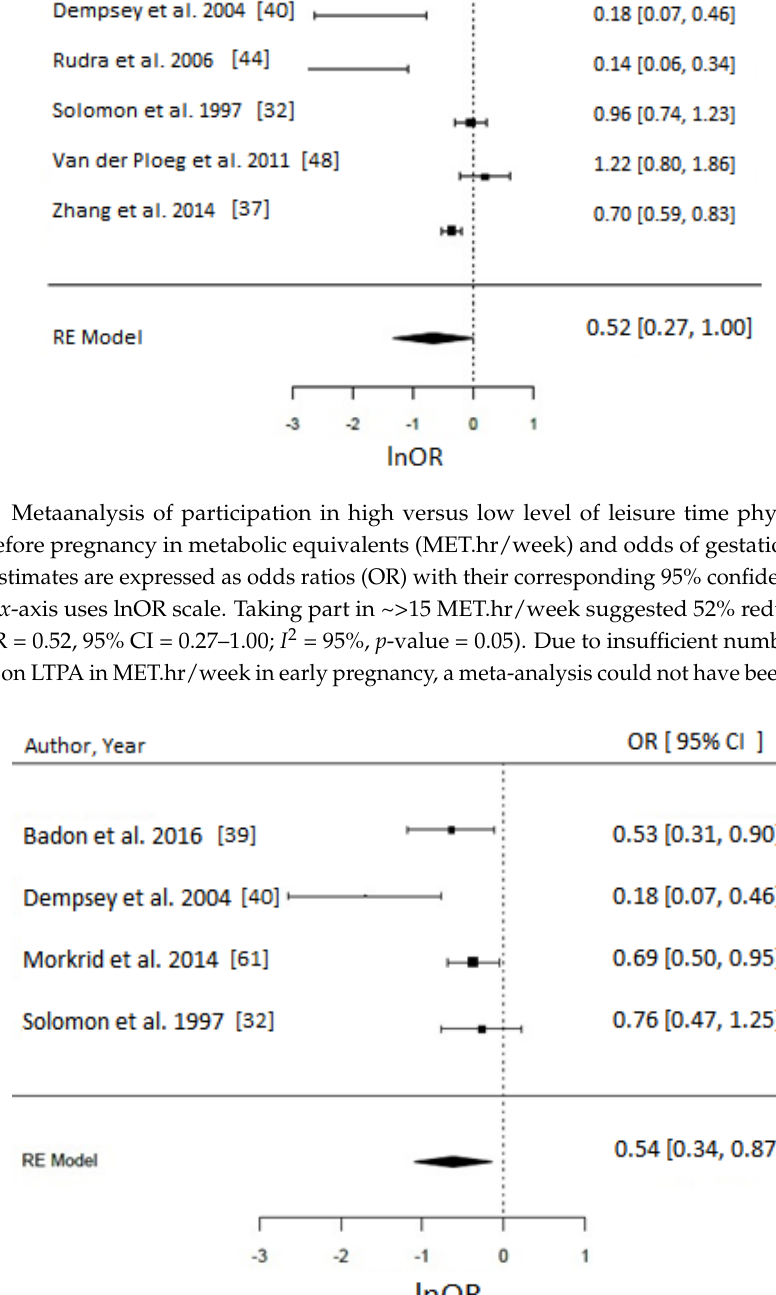
Figure 6. Meta-analysis of high versus low level of leisure time physical activity (LTPA) before pregnancy reported in hr/week and odds of gestational diabetes (GDM). Estimates are expressed as odds ratios (OR) with their corresponding 95% confidence intervals, however x -axis uses lnOR scale. Longer hours (>90 min/week) of LTPA/week reduced the odds of GDM by 46% (OR = 0.54, 95% CI = 0.34–0.87; I 2 = 70% (medium), p -value = 0.01). Due to insufficient number of studies reporting on LTPA in hr/week in early pregnancy, a meta-analysis could not have been performed.